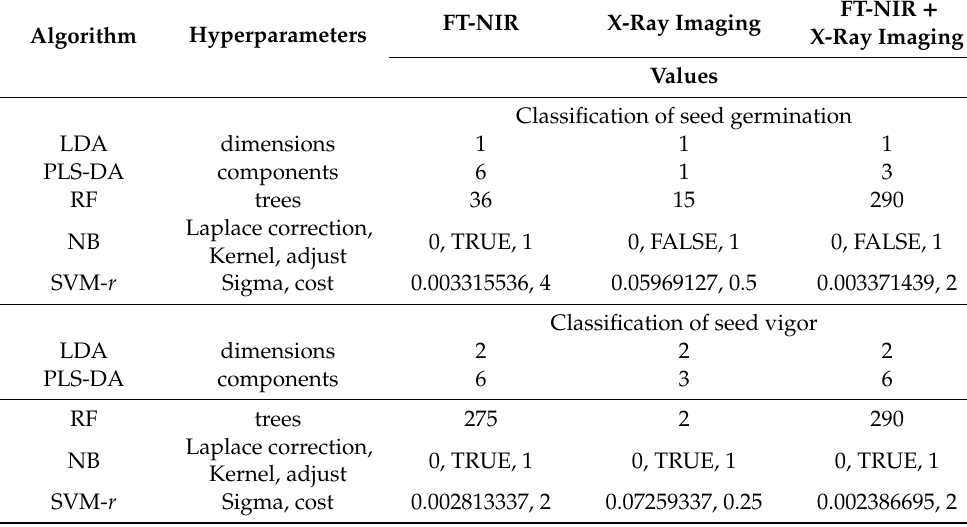
Table 1. Hyperparameters used in the machine learning